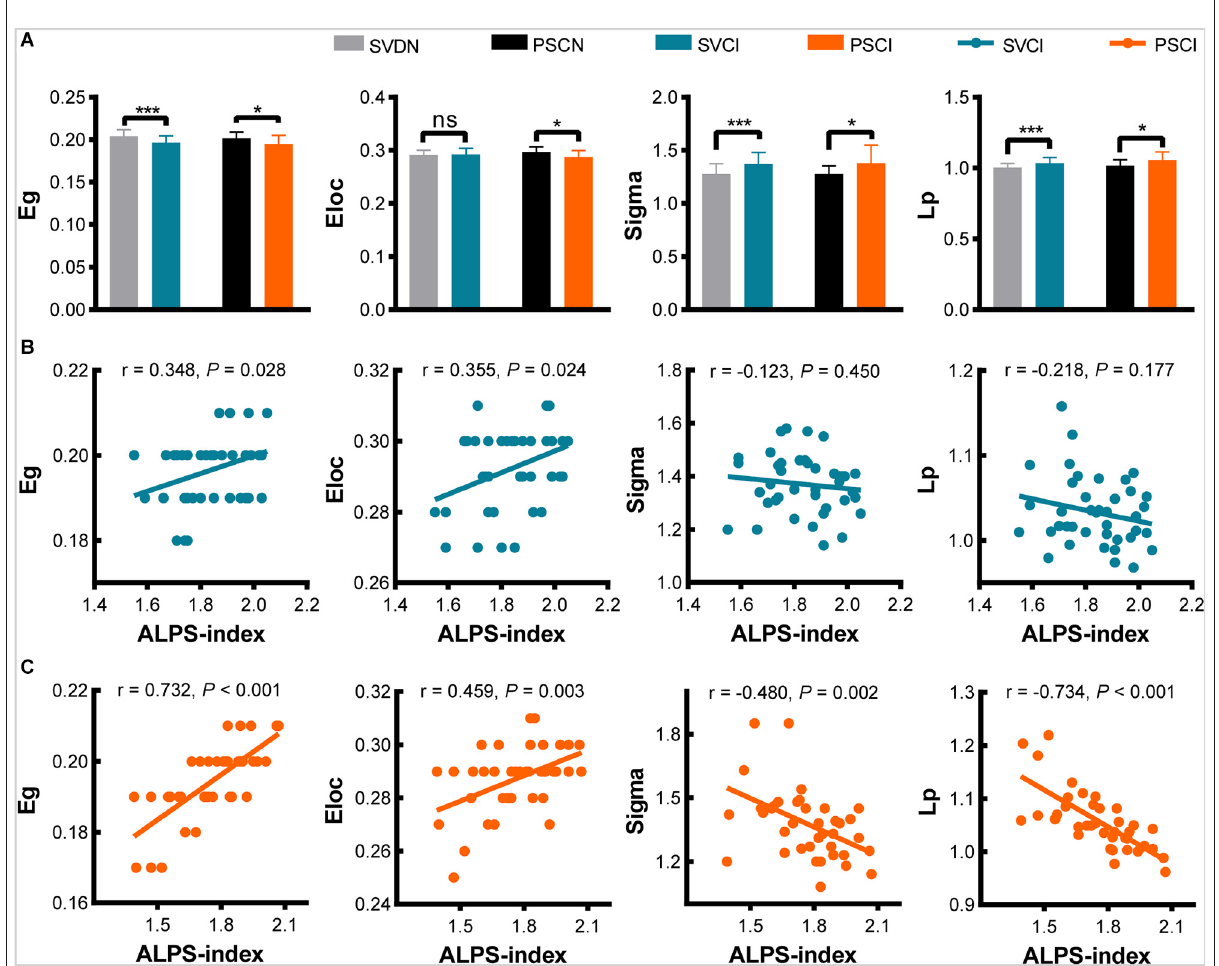
FIGURE3 Differences of network topology metrics (Eg, Eloc, Sigma, Lp) between SVDN and SVCI, PSCN, and PSCI (A) . Correlation between ALPS-index and network topology metrics in SVCI (B) and PSCI (C) . * P < 0.05, *** P < 0.001; ns, no statistical difference; Eg, global efficiency; Eloc, local efficiency; Lp, global shortest path length; ALPS, analysis along the perivascular space; SVDN, cerebral small vessel disease with normal cognition; SVCI, cerebral small vessel disease cognitive impairment; PSCN, post-stroke cognitively normal; PSCI, post-stroke cognitive